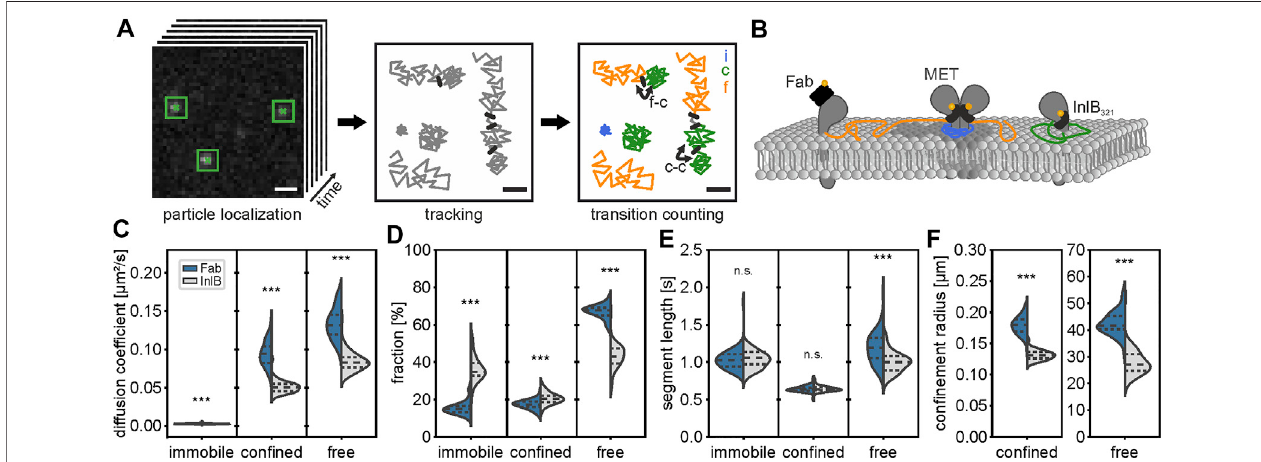
FIGURE1| Analysispipelineofsingle-particletrackingdataoftheMETmembranereceptor. (A) Diffraction limitedsignalofmembrane-bound fl uorescently labeled receptors is localized with subpixel accuracy (scale bar 1 μ m) (left). Localizations are connected over time to trajectories and changes in diffusion behavior within a trajectory give separated segments (schematic scale bar 100 nm) (middle). Segments are classi fi ed into the diffusion states immobile (blue), con fi ned (green), and free (orange) (right). Gray segments are below the necessary length to be classi fi ed and have no diffusion state label. Transitions between diffusion states are counted. (B) Membrane bound MET receptors are labeled extracellularly with a monoclonal Fab fragment that binds but does not activate and with InlB that binds and activates the receptor. Both ligands carry ATTO 647N as a fl uorescent label. The movement of bound labels is detected and analyzed. The segment properties (C) diffusion coef fi cient, (D) population of diffusion states, (E) segment length, and (F) con fi nement radius are displayed as violin plots; dashed lines mark the quartiles. For each condition, Fab (blue) and InlB (gray), the average segment values of 60 cells are